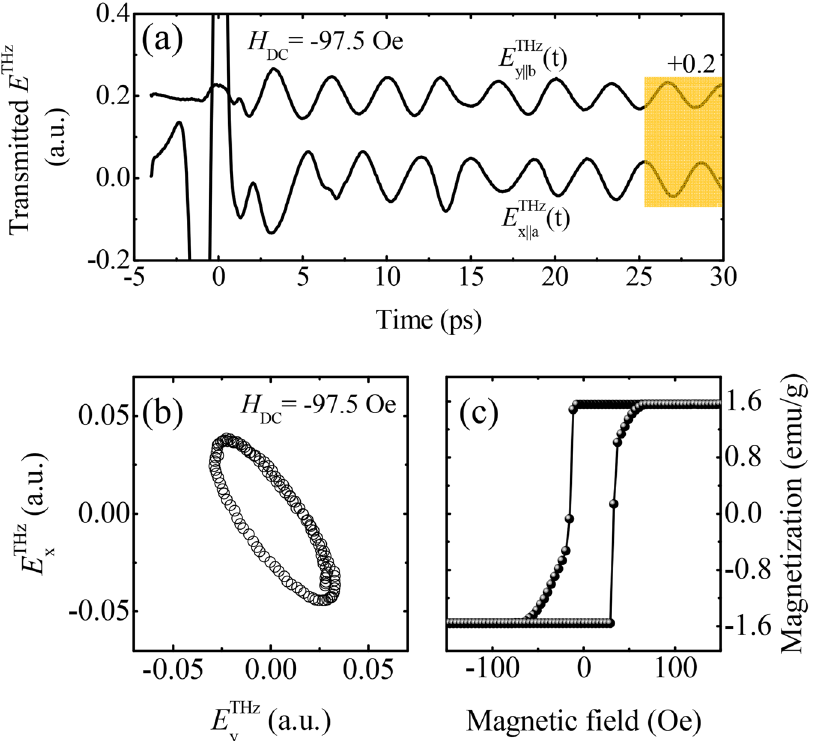
Figure 5. THz emission waves and magnetic hysteresis curve. ( a ) THz waveforms transmitted through the sample when the magnetic field is parallel to the y-axis. YFeO 3 is saturated fully under the external magnetic aTHz and E bTHz are extracted using a pair of wire-grid polarizers set at 45° and − 45° from the field of − 97.5 Oe. E x y bTHz is shifted upward by + 0.2 for clarity. ( b ) Two-dimensional trajectories of emissions in a x -direction. Here, E y temporal window between 25 ps and 30 ps. ( c ) Magnetization hysteresis curve measured using a sample vibrating magnetometer. All data are quoted from ref.